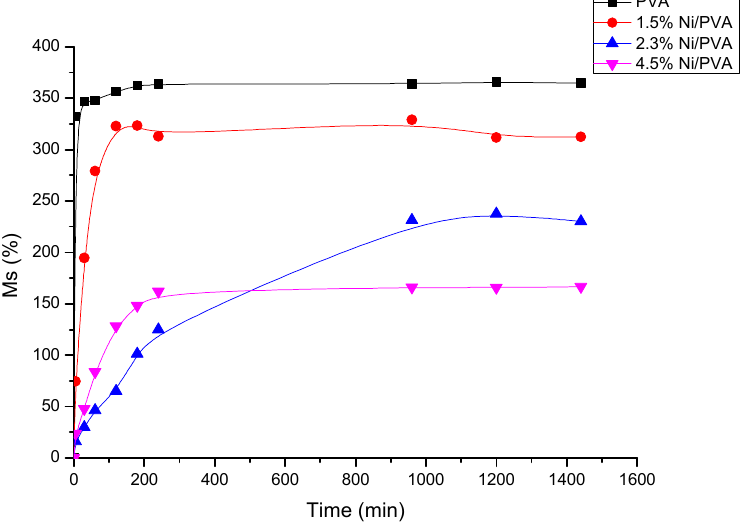
Figure 7. Dimension change ( L s ) versus immersion time for PVA gel and PVA/Ni magnetic gel.